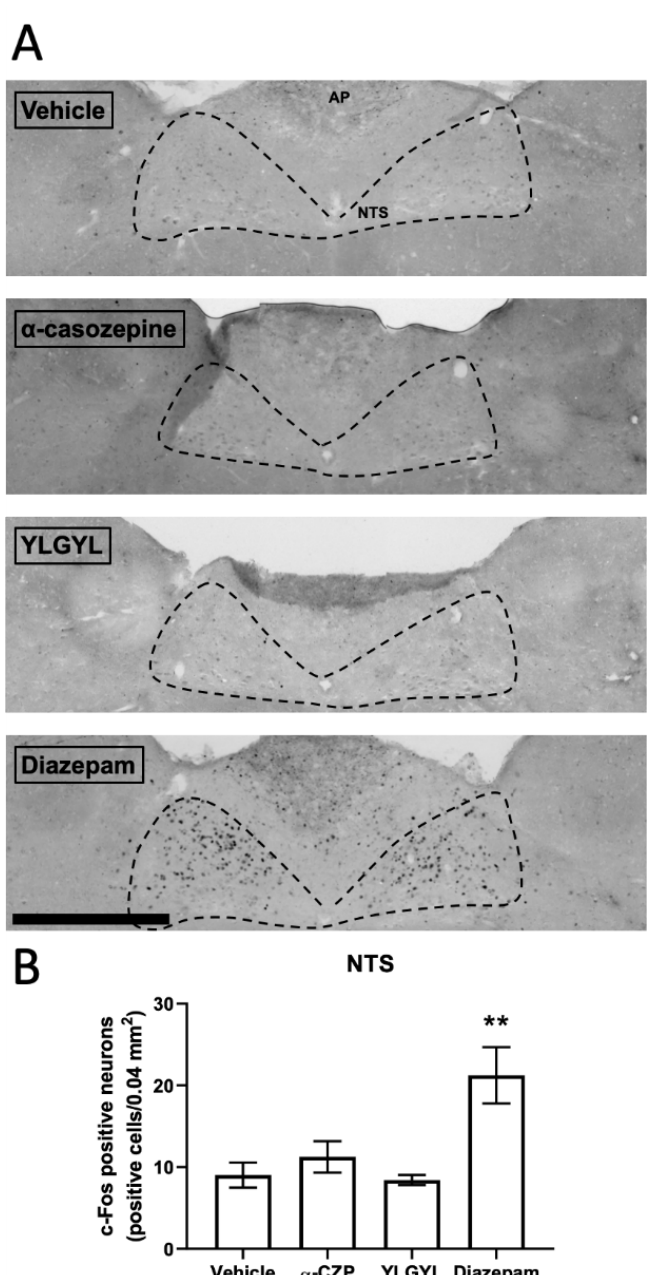
Figure 3. The e ff ects of α -casozepine ( α -CZP, 1 mg / kg, IP), YLGYL (0.5 mg / kg, IP), or diazepam (1 mg / kg, IP) on anxiety-induced c-Fos immunoreactivity in the NTS. ( A ) Photomicrographs displaying the e ff ects of the vehicle, α -CZP, YLGYL, or diazepam on anxiety-induced c-Fos immunoreactivity in the NTS (coronal sections, bregma–7.56 mm). The green channel was extracted, and the colours were inversed while the contrast was increased to 40% for better visualisation. Scale bar: 500 µ m. ( B ) Corresponding densities of c-Fos immunopositive cells (displayed as number of positive cells / 0.04 mm 2 ). Data are mean ± SEM ( n = 4 / group). Results were analysed using a one-way analysis of variance (ANOVA) followed by a Bonferroni post hoc test to compare the e ff ect of α -CZP, YLGYL, and diazepam to the vehicle (** p < 0.01). AP: area postrema; NTS: nucleus of the tractus solitarius.